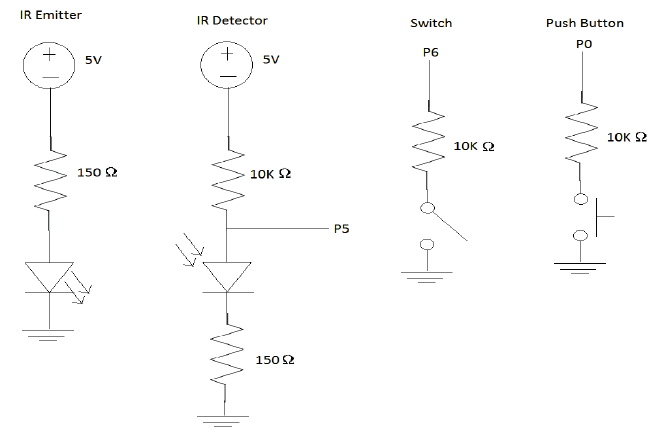
Fig. 3 Schematic of IR system, switch, and push